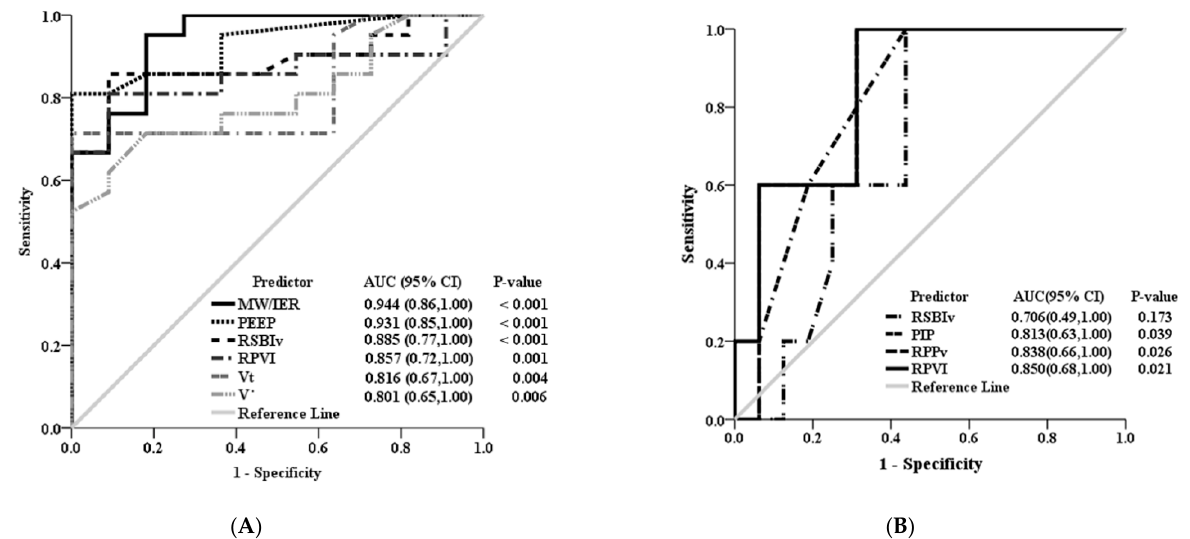
Figure 1. The areas under the receiver operating characteristic (ROC) curves (AUCs) and 95% confidence intervals (CIs) of mechanical ventilation parameters in predicting the development of ARDS and the mortality in patients. ( A ) The AUCs and 95% confidence intervals (CIs) of PEEP, RSBIv, RPVI, V T , and V(cid:4662) in predicting the morbidity of ARDS patients were 0.931, 0.885, 0.857, 0.816, and 0.801, respectively. ( B ) The AUCs of RPVI, RPPv, RSBI, and PIP in predicting the mortality of ARDS patients were 0.850, 0.838, 0.706, and 0.813, respectively.